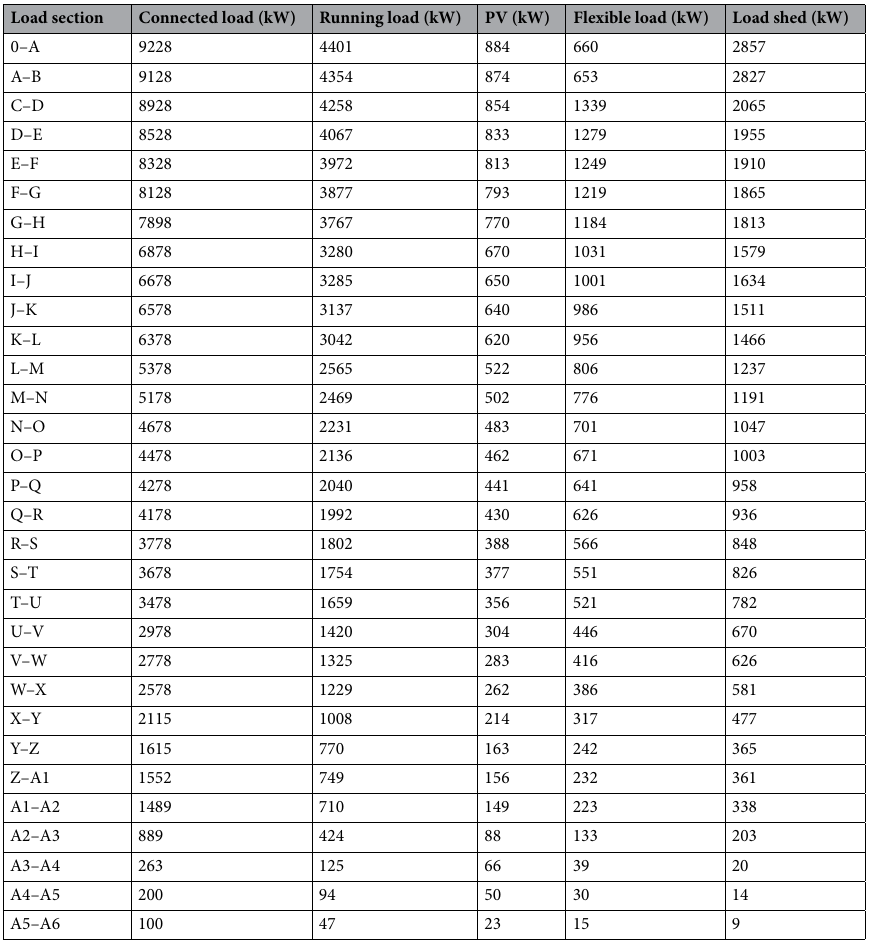
Table 8. VPP section-wise autonomous response.